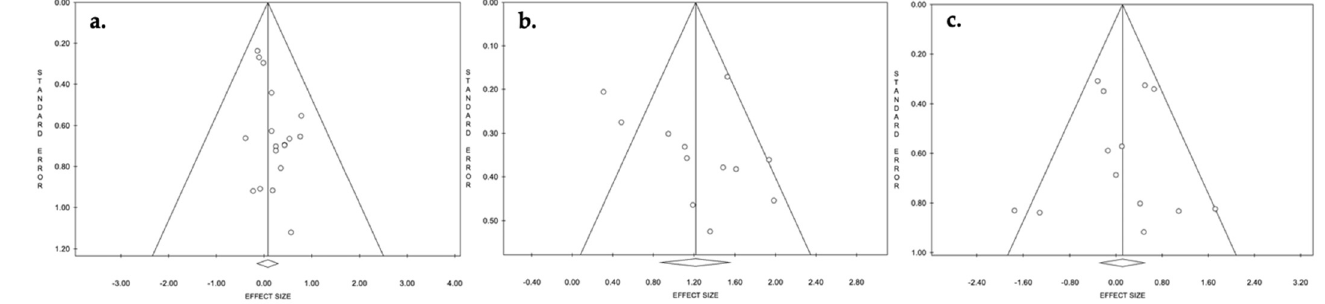
Figure 4. Funnel plot of effect sizes for publication bias of the comparative studies evaluating PJI recurrences ( a ), active knee flexion at last follow-up ( b ), and non-infection-related peri-operative local complications ( c ).